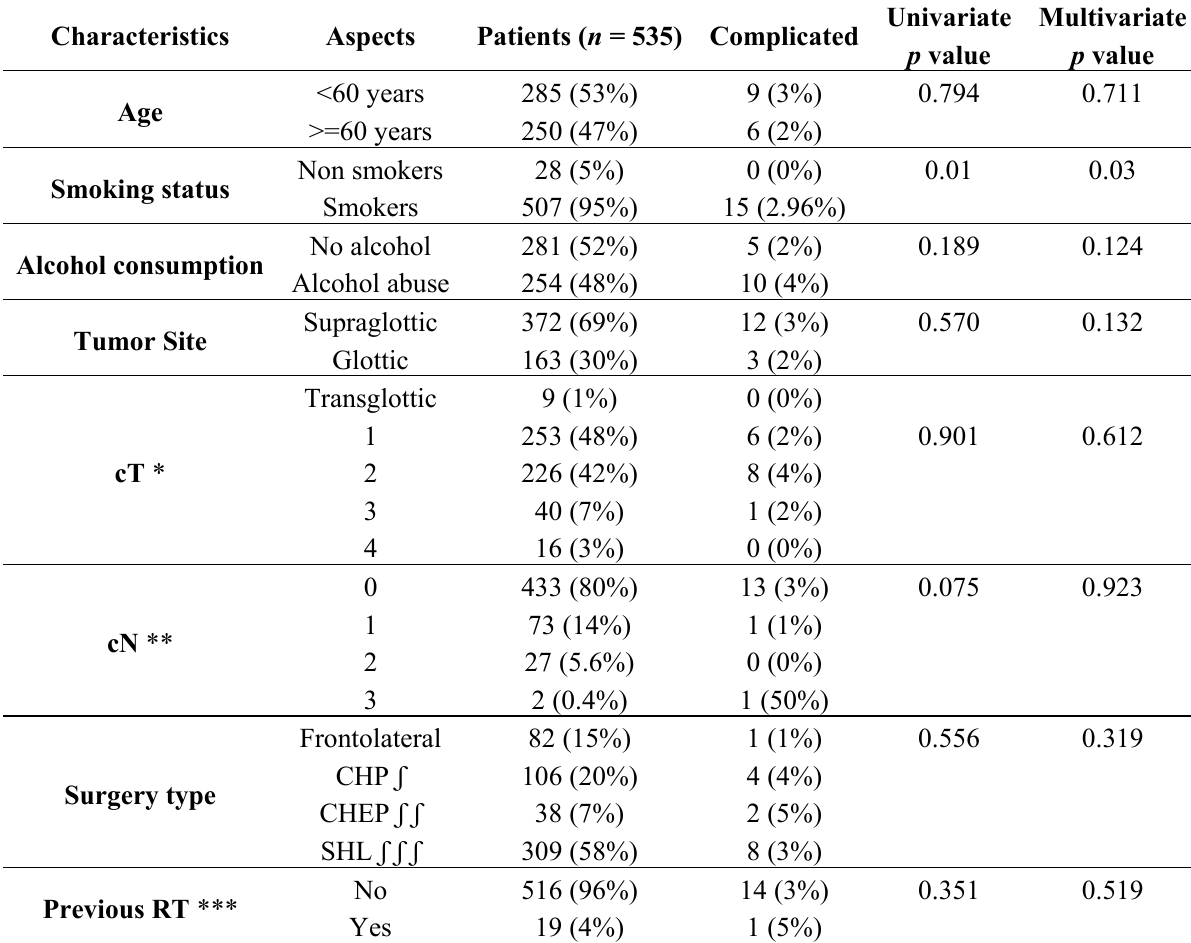
Table 5. Factors predictive for pharyngocutaneous